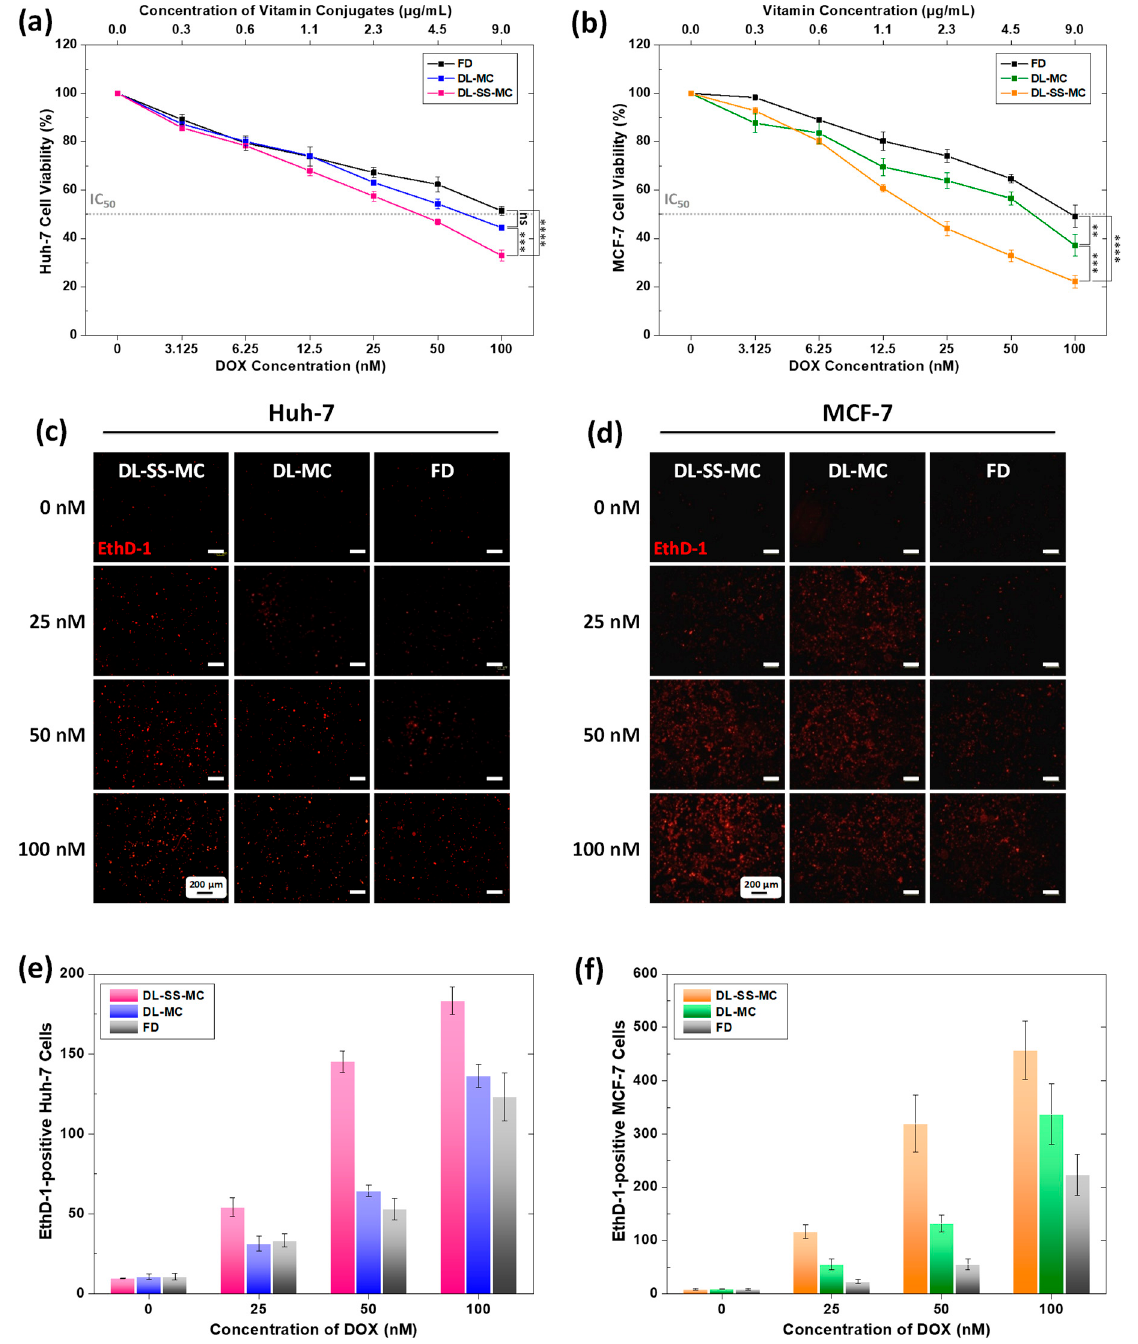
Figure 5. Viability of Huh-7 ( a ) and MCF-7 cells ( b ) treated with DL-SS-MC, DL-MC, and FD for 24 h, as measured in a CCK-8 assay. Data are presented as the mean ± SD of triplicate experiments: ns (not statistically significant, p > 0.05), ** p < 0.01, *** p < 0.001, **** p < 0.0001. Fluorescence microscopy images of EthD-1-stained Huh-7 cells ( c ) and MCF-7 cells ( d ) incubated with DL-SS-MC, DL-MC, and FD for 24 h (scale bar = 200 μ m). The number of dead Huh-7 cells ( e ) and MCF-7 cells ( f ) were quantified.